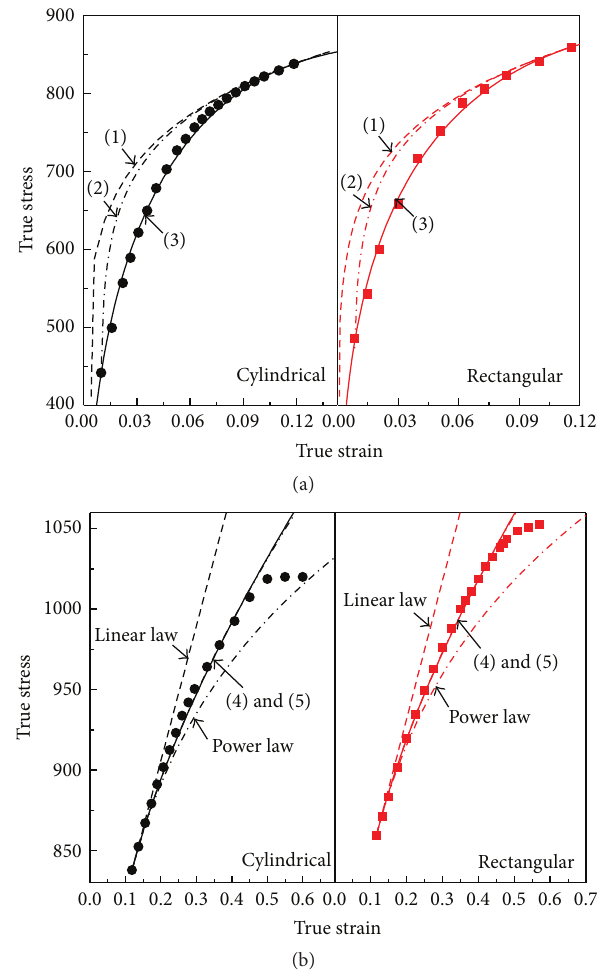
Figure 9: Fitting curves for different hardening laws: (a) before necking and (b) after